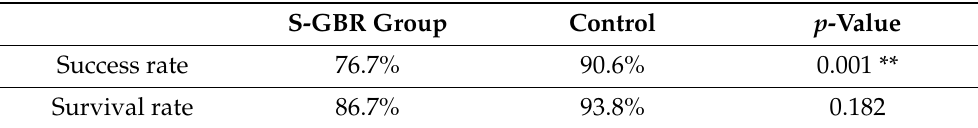
Table 7. Success rate and survival rate at 24-months